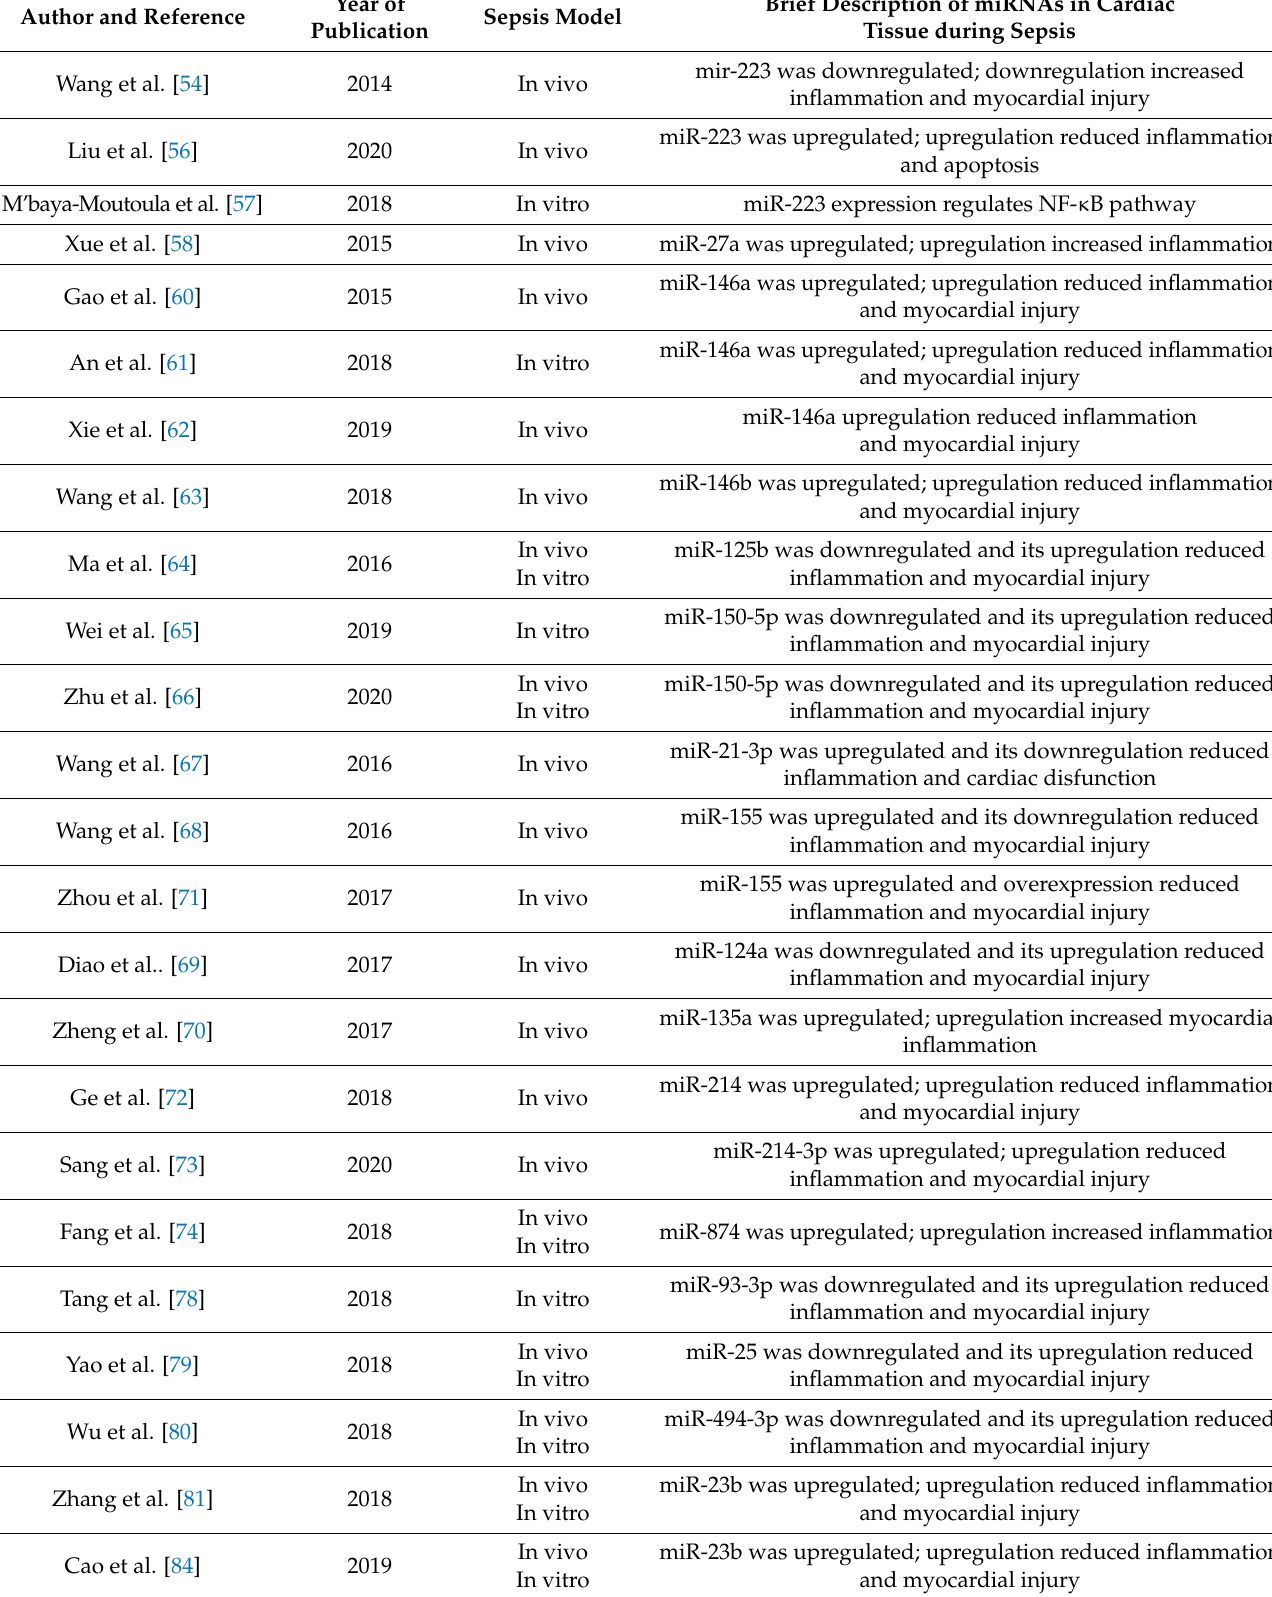
Table 2. miRNA expression in sepsis-related heart